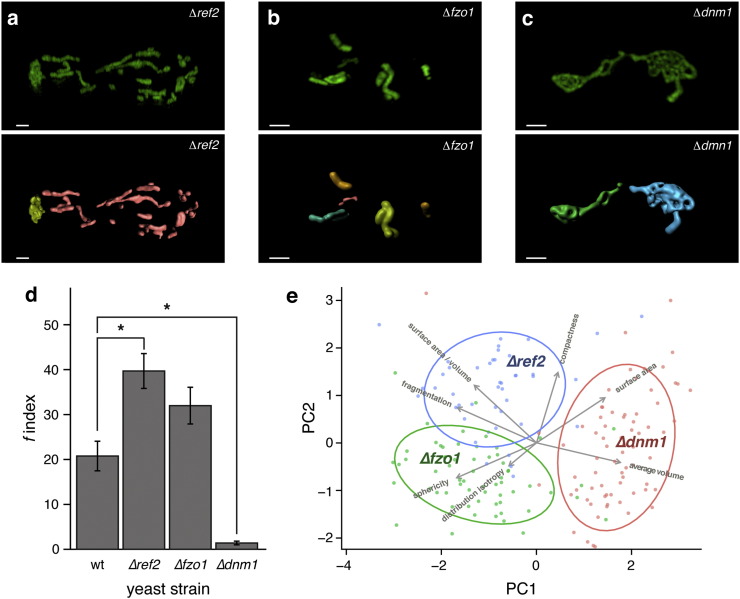
Quantitative analysis of mitochondrial network morphologies in fusion/fission protein deletion mutant cells.(a–c) Measurement of mitochondrial network morphology in yeast cells with defects in fusion/fission proteins using 3D-SIM. (upper panel) PreSU9-GFP (green) image of a typical mitochondrial network in a) ∆ref2, b) ∆fzo1 and c) ∆dnm1 cells. Scale bar = 1 μm. (lower panel) 3D reconstruction of the network, with individual fragments colour-coded according to their relative size. Scale bar = 1 μm. Images are directly comparable to wild-type cells shown in Fig. 1d.(d) Quantification of the fragmentation index f of mitochondrial networks in wild type and single-gene deletion mutants. n = 30; * p < 0.01; error bars represent +/− SEM.(e) Principal component (PC) analysis of mitochondrial geometry determined by preSU9-GFP and super-resolution microscopy. Separation in PC1 is mostly driven by fragmentation, while sphericity and compactness contribute to separation in PC2. n = 30 cells per genotype.